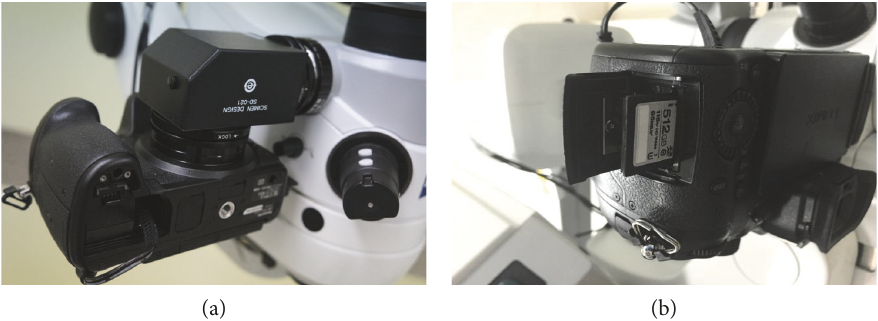
Figure 1: Installed image of 4K camera. (a) The LUMIX DMC-GH4 (Panasonic, Japan) was attached to the LUMELA 700 (ZEISS, Germany) surgical microscope with an SD-021 adaptor (SCIMEN Design Ltd., Japan). (b) Motion picture of 3840 × 2160 (8.29 million pixels: 4K) with 29.97 frames per second in progressive mode can be recorded on a 512 GB SD memory card for approximately 11